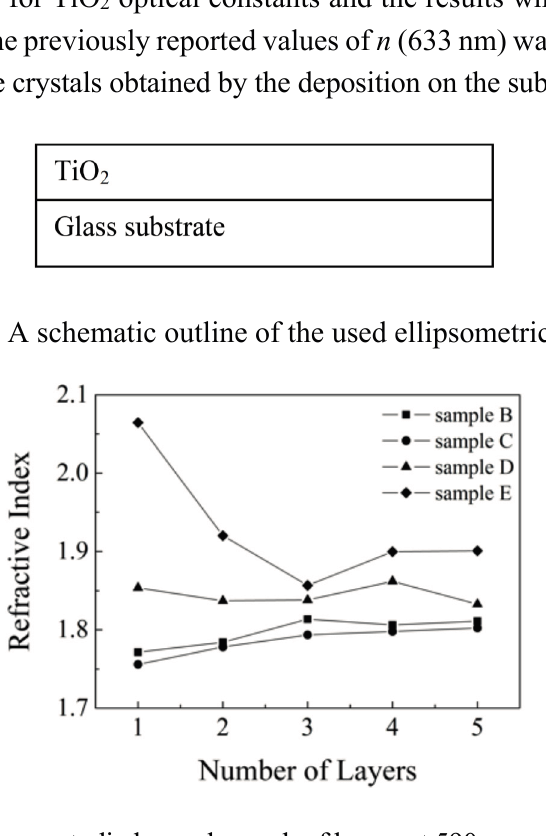
Figure 7. Refractive index on studied samples each of layers at 590 nm wavelength after fitting.